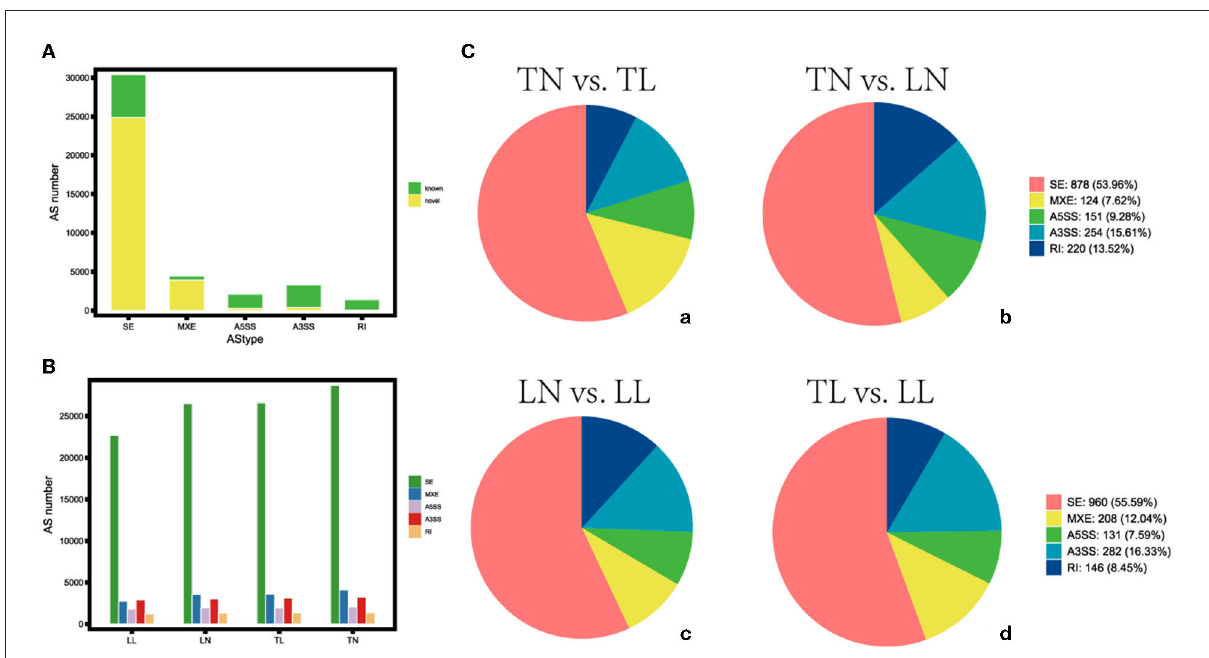
FIGURE1 Distribution of the different types of alternative splicing (AS) events. (A) Distribution of the known and novel AS. (B) The number of AS events among four groups. (C) Different types of AS events (a) between TN and TL, (b) between TN and LN, (c) between LN and LL, and (d) between TL and LL